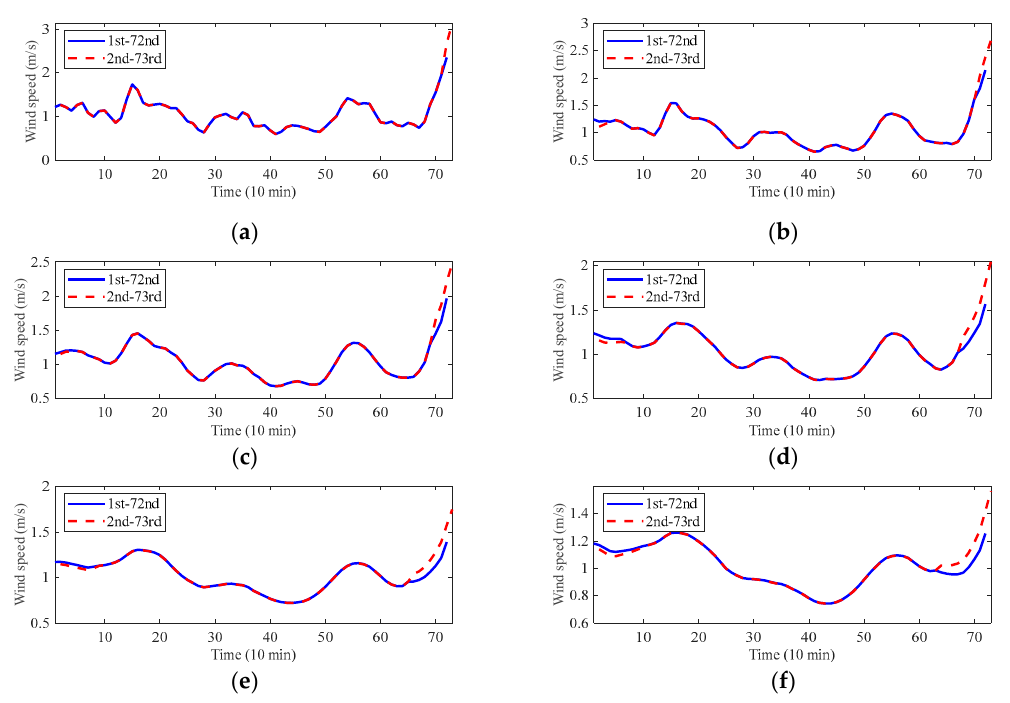
Figure 8. End effects of different window lengths: ( a ) L = 2; ( b ) L = 3; ( c ) L = 4; ( d ) L = 6; ( e ) L = 8; ( f ) L = 10.